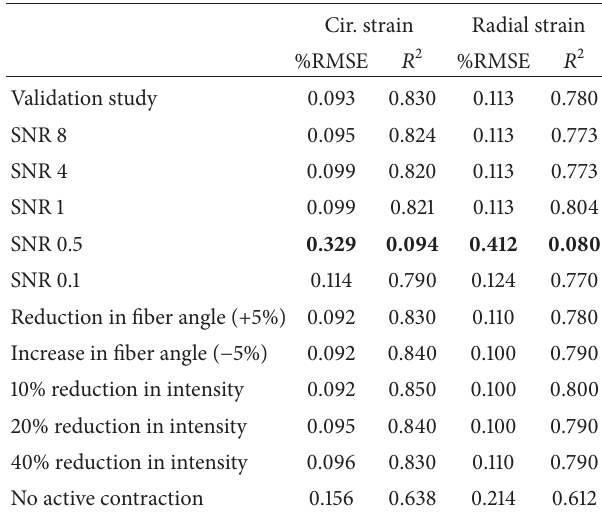
Table 2: Sensitivity results for Heart 2. The results of Heart 2 analysesshowsimilartrendstothoseseenintheHeart1analyses.An SNR level of 0.5 (bold) caused severe degradation of the registration results also with large increases in %RMSE and a reduction of the 𝑅 2